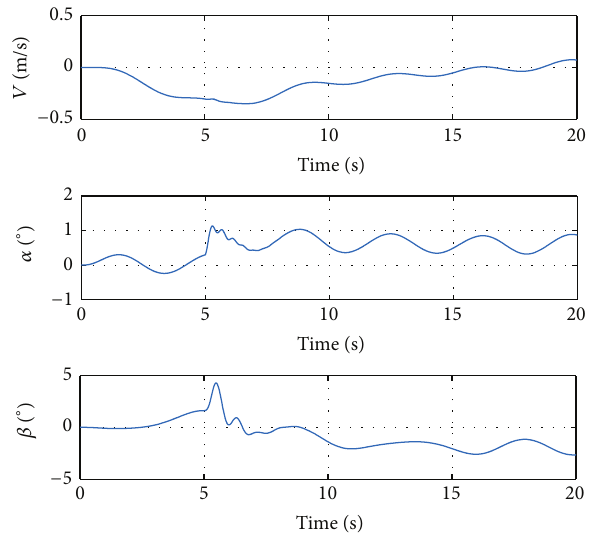
Figure 8: Response of the other states in simulation with sinusoidal input